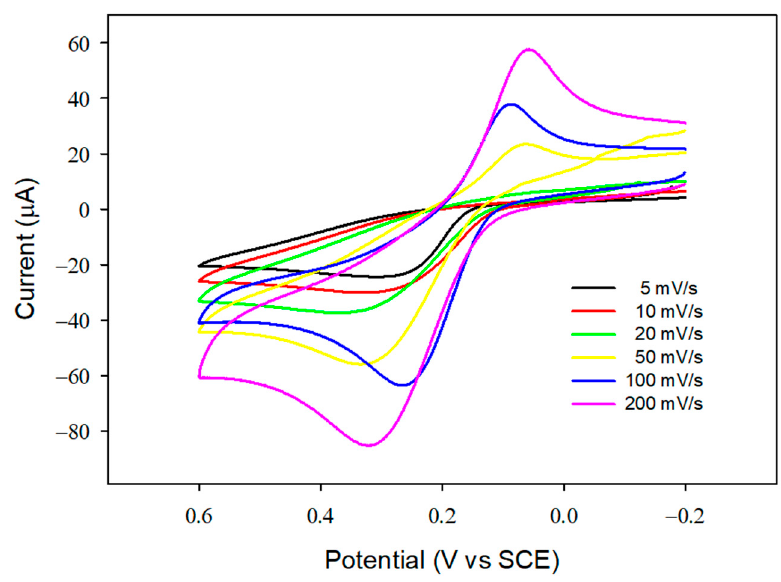
Figure 1. Cyclic voltammograms relevant to 2.5 mM of dopamine in phosphate buffer solution (I = 0.1 M, pH 7) at a bare platinum electrode acquired by varying the scan rate in the range of 5–200 mV/s.